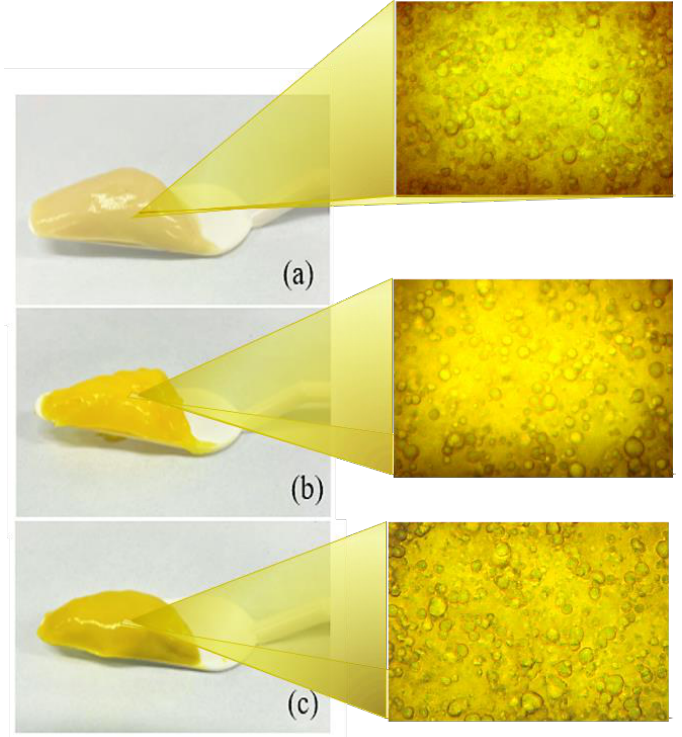
Figure 1. Macroscopic and microscopic (original magnification × 400) characteristics of emulgel systems containing andiroba oil (8%, w / w ), Carbopol 934P ® (1%, w / w ), and: ( a ) propolis extract (PE; 8%, w / w ); ( b ) curcumin (CUR; 0.1%, w / w ); ( c ) PE (8%, w / w ) plus CUR (0.1%, w / w ).